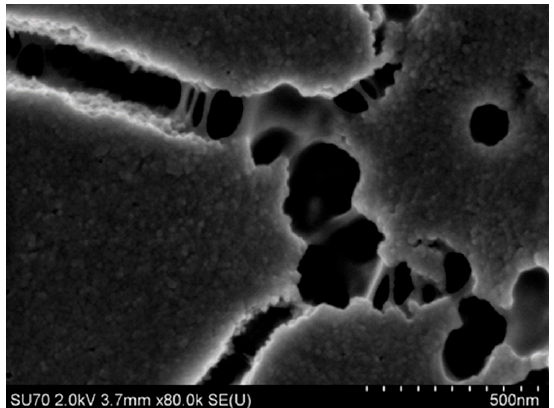
Figure 4. Example morphology of a mixture of the Remasol-aluminosilicate system after gelation. As a standard, binder stability is ensured by maintaining an appropriate pH (usually strongly alkaline) by introducing sodium or ammonium hydroxide into the solution. As shown in Figure 5, OH - ions react with the H + ion of the hydroxyl group from the surface of the SiO 2 particles. The reaction produces a water molecule, and an unbalanced negative charge appears on the surface of the SiO 2 particle. The negatively-charged SiO 2 particles repel each other so that they remain uniformly dispersed in the dispersing medium without agglomeration. A major inconvenience with this stabilization is that the particle charge strongly depends on the pH. Unavoidable changes in pH during mix preparation and use may result in accelerated ageing of the binder or premature gelation. The pH should therefore be continuously monitored and maintained at an appropriate level